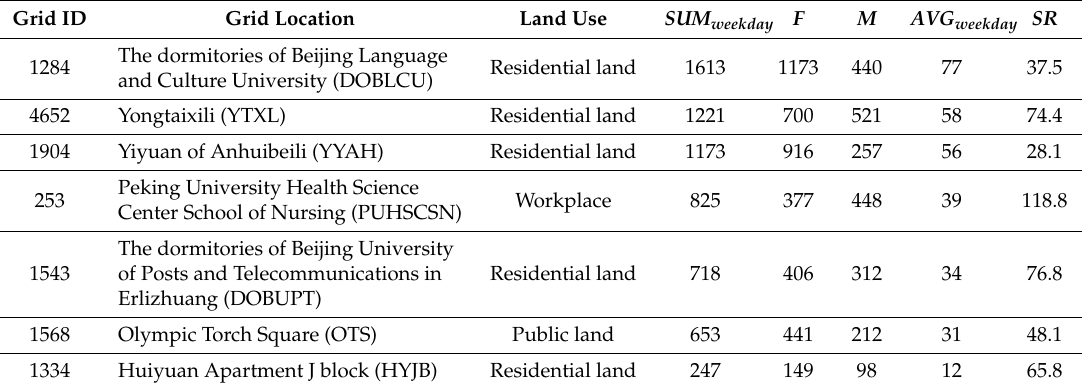
Table 3. The partial statistical results of the quantities of users on weekdays in June 2014.